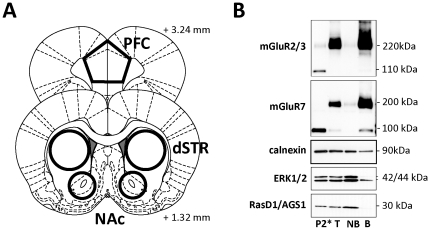
Analysis of mGluR2/3 and mGluR7 surface vs. intracellular distribution in rat brain synaptosomes.(A) Rat brain atlas coordinates (adapted from [77]) used for tissue dissection and synaptosome preparation. (B) Representative immunoblots showing surface vs. intracellular distribution of mGluR2/3 and mGluR7 receptors (as well as marker proteins: calnexin, ERK1/2 and RasD1/AGS1) in synaptosomal fraction prepared from the dSTR. P2* - synaptosomal fraction resolved under strongly reducing conditions (100 mM DTT); T – total synaptosomal fraction after biotinylation resolved under weakly reducing conditions (>10 mM DTT); NB – non-biotinylated (intracellular) proteins; B – biotinylated (surface) proteins isolated by precipitation with streptavidin-agarose beads.